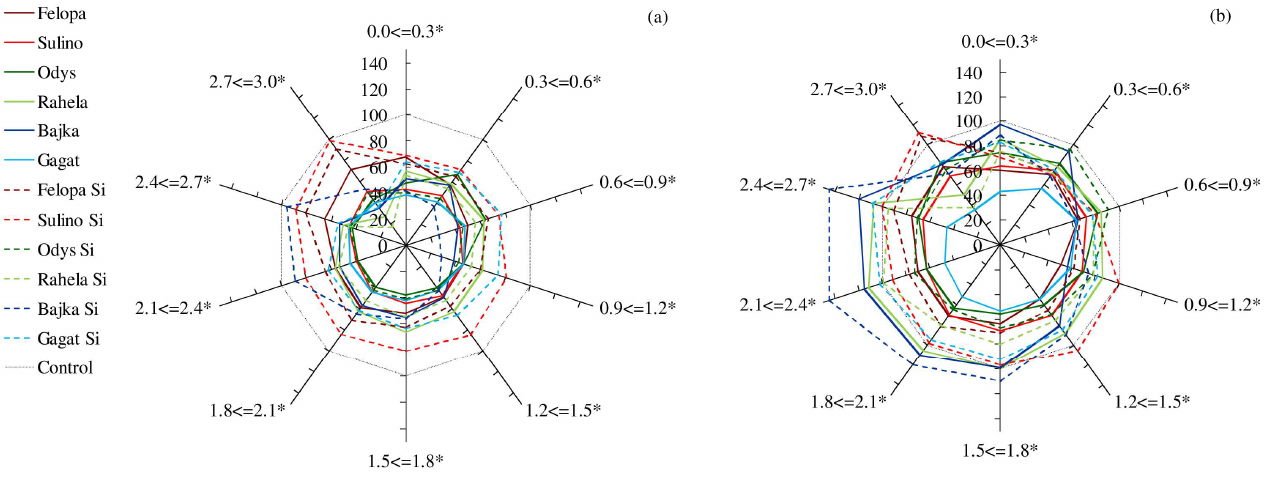
Figure 3. Root length distribution (% relative to control) of F. braunii (cvs. of Felopa and Sulino), F. arundinacea (cvs. of Odys and Rahela), and L. perenne (cvs. of Bajka and Gagat) in ten diameter classes (0.0 <= 0.3, 0.3 <= 0.6, 0.6 <= 0.9, 0.9 <= 1.2, 1.2 <= 1.5, 1.5 <= 1.8, 1.8 <= 2.1, 2.1 <= 2.4, 2.4 <= 2.7, and 2.7 <= 3 mm) depending on the term of water deficit, ( a ) spring drought (D1) and ( b ) summer drought (D2); *—significant differences in interaction cultivars and water and Si conditions ( p ≤ 0.05).